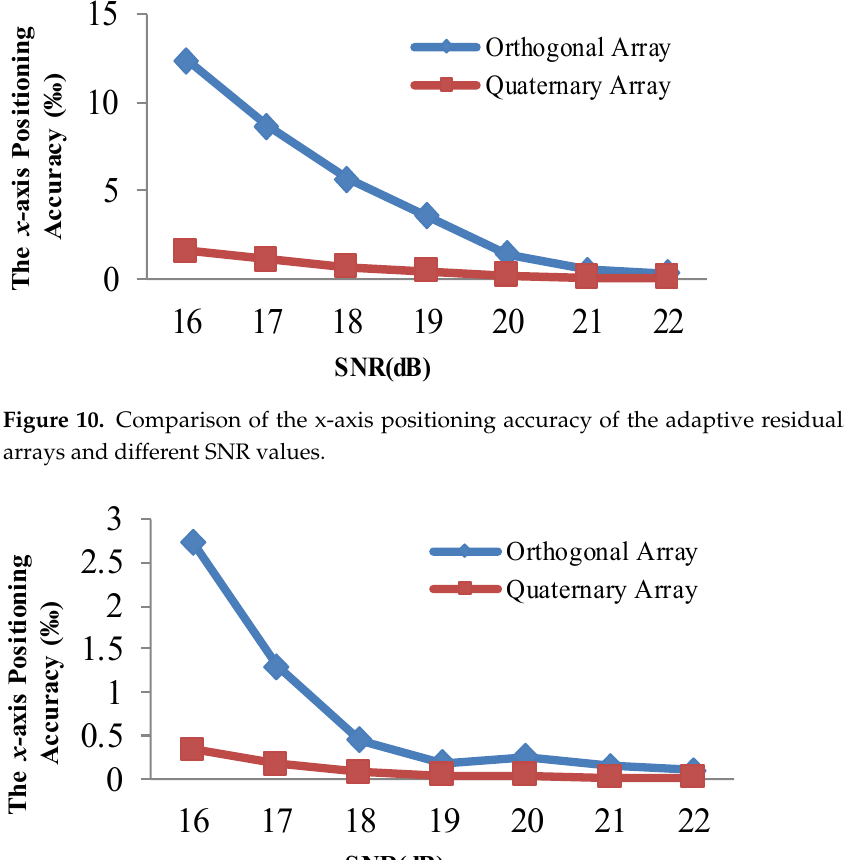
Table 5. The positioning processing time of the three methods.